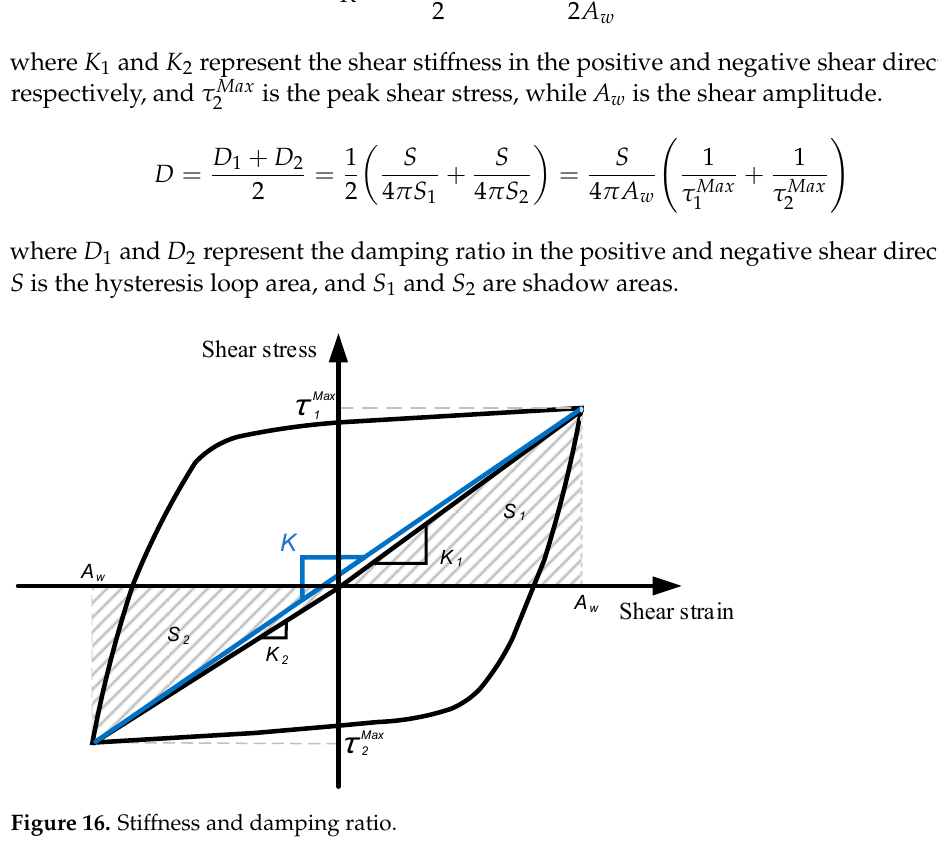
the shear stiffness–cycle number and damping ratio–cycle number were plotted, respec- tively. 3.2.1. The Influence of Normal Stress It has been reported that different normal stresses lead to an additional cyclic shear stiffness and damping ratio of the interface [30,31]. As shown in Figure 17, in the K–N (shear stiffness–cycle number) curve, a weakening feature tends to appear under all nor- mal stress conditions. For the same number of cycles, with the increase in normal stress, shear stiffness increased, and its softening trend became apparent with the number of cy- cles, which was consistent with the influence of normal stress on shear strength.